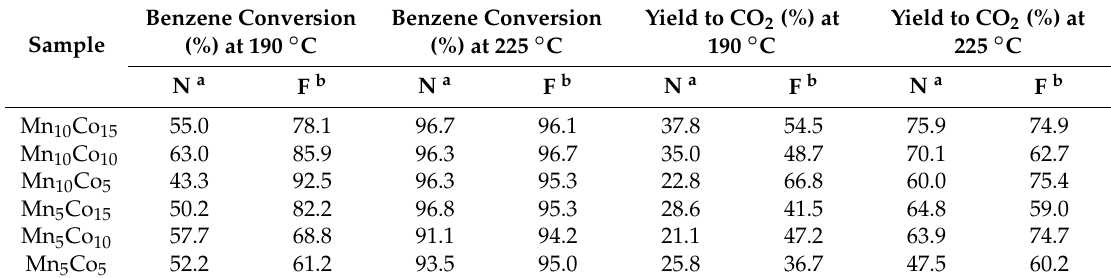
Figure 6. Average conversion rates of benzene estimated over three runs on ( a ) Mn x Co y /N and ( b ) Mn x Co y /F during the light-off experiments. Table 3. Conversion rates of benzene and yields of CO 2 at reaction temperatures of 190 °C and 225 °C.